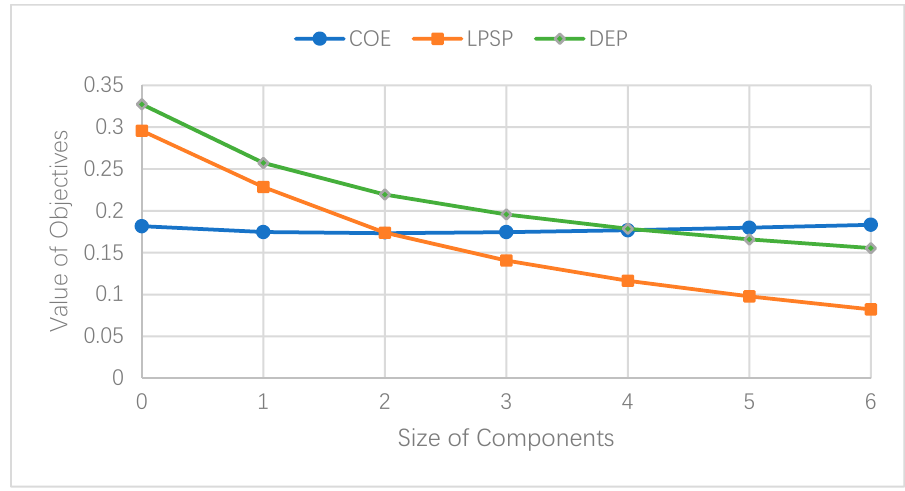
Figure 20. Sensitivity analysis results of BSS.